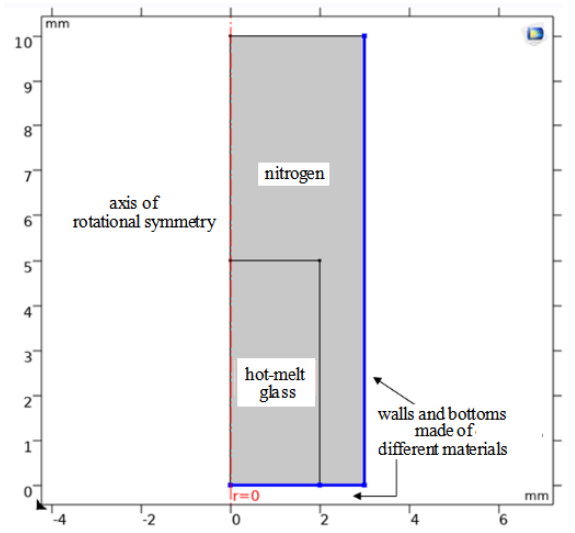
Figure 1. Final simulation model .